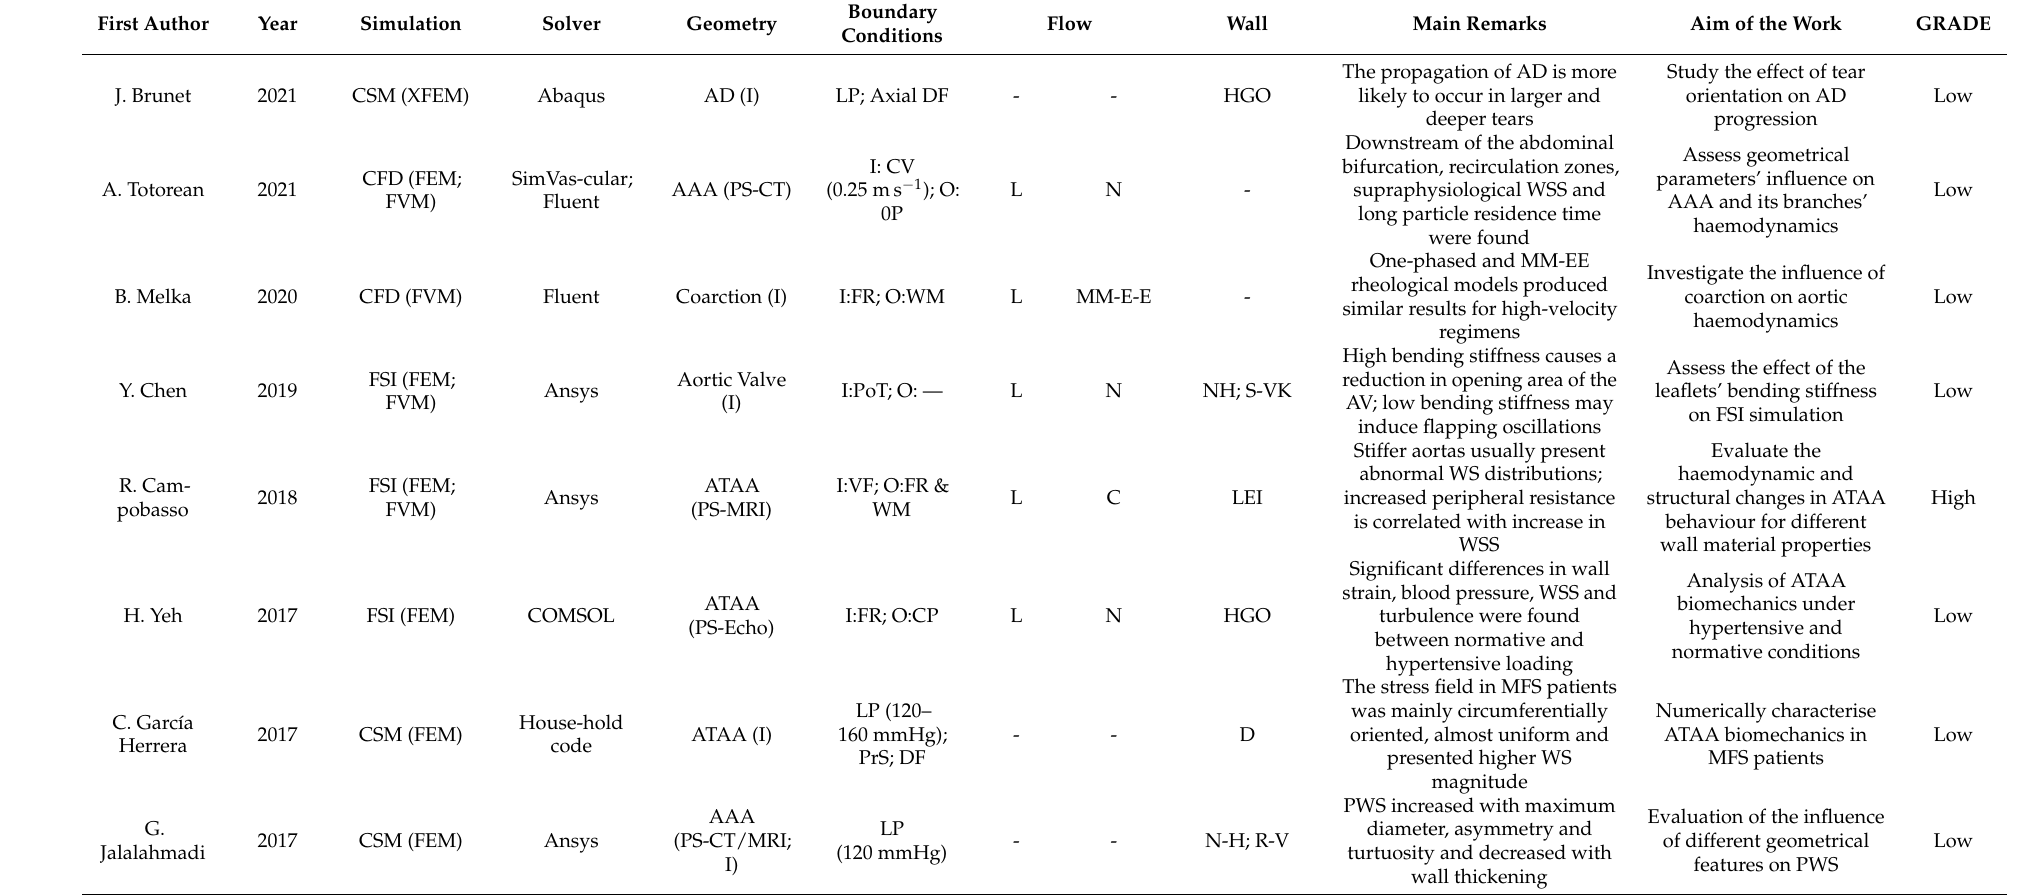
Table 2. Studies focused on study the biomechanical environment of healthy and diseased aortas ( n = 31